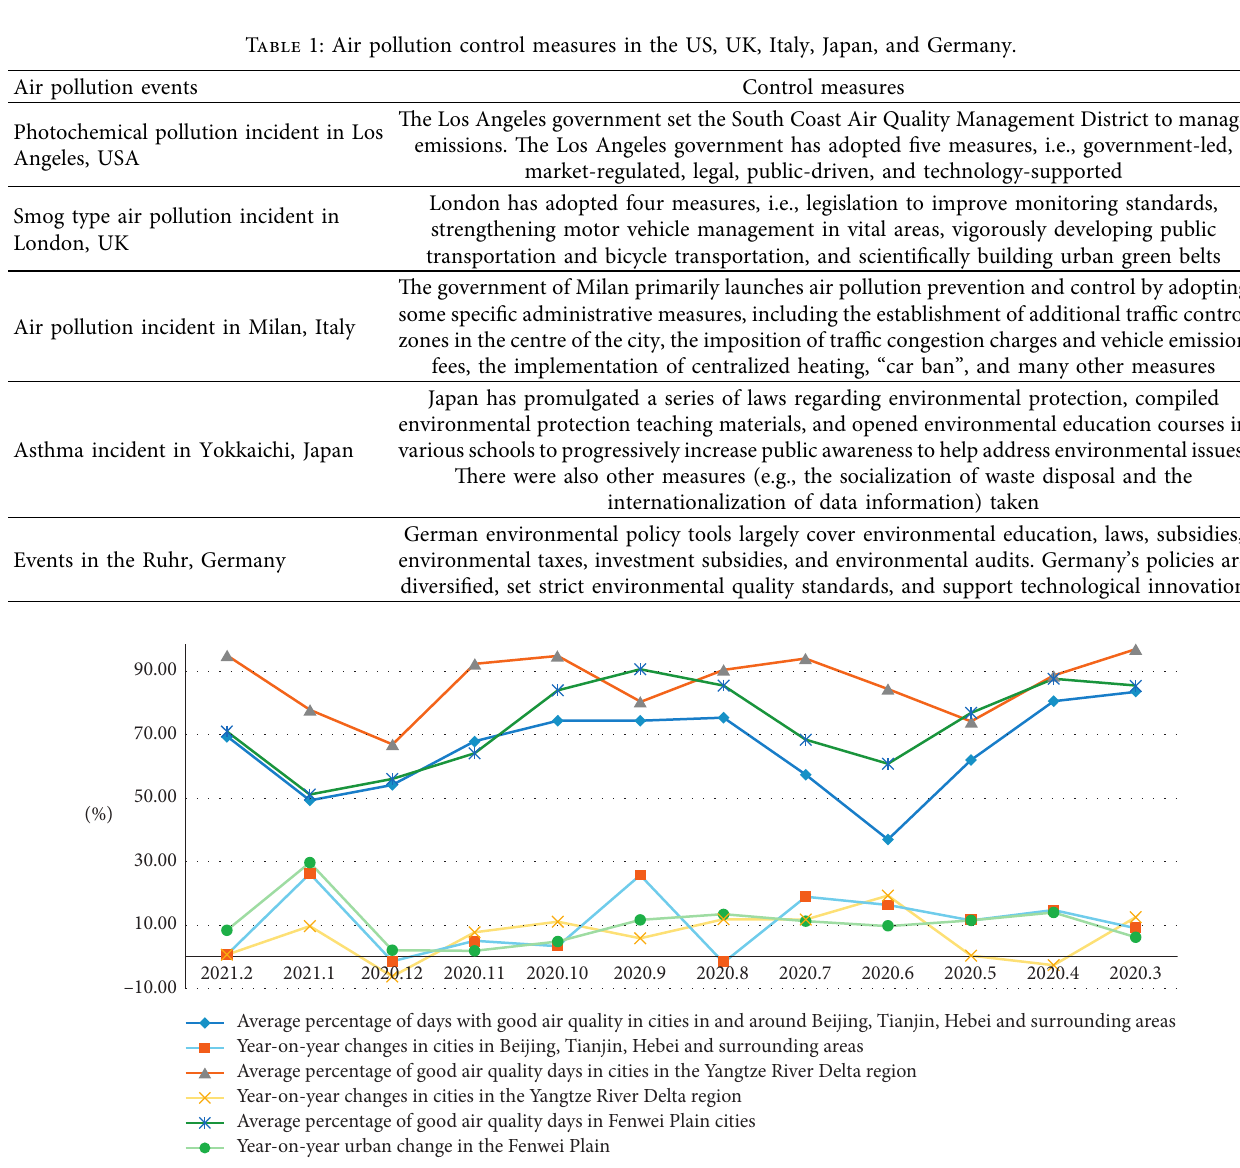
Figure 1: Air quality conditions in three key regional